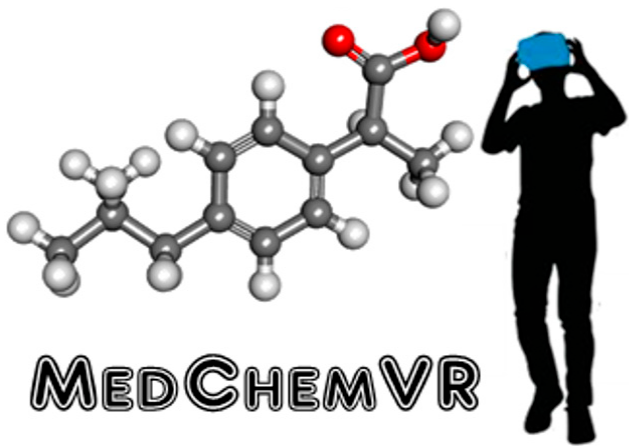
Figure 3. Screenshot of the introduction screen of the prototype MedChemVR application.